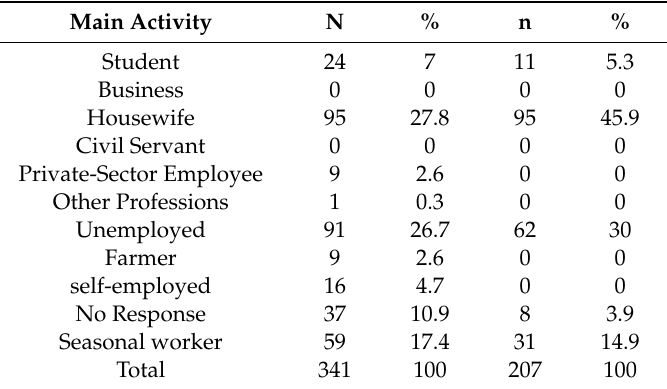
Table 3. Socio-professional activities in